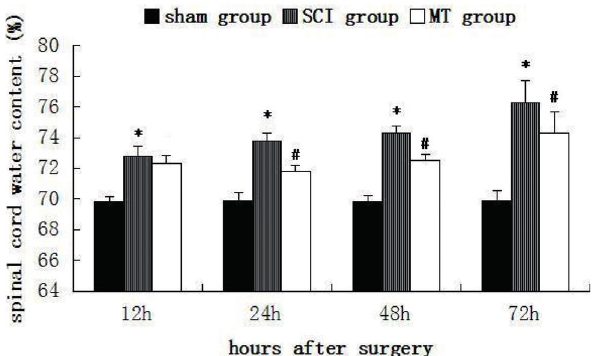
Fig. 2. Changes of AQP4 positive cells expression by IHC method at 24 and 72 h after injury (A: 24 h of Sham group, B: 24 h of SCI group, C: 24 h of MT group, D: 72 h of Sham group, E: 72 h of SCI group, and F: 72 h of MT group). The number of AQP4 positive cells in gray matter regions in SCI group was significantly up-regulated compared with that in Sham group at 24 and 72 h after injury. The number of AQP4 positive cells in MT group was significantly down-regulated compared with that in SCI group at 24 and 72 h after injury. Data present mean ± SD (n=5, * P <0.05 between Sham group and SCI group, # P <0.05 between MT group and SCI group, Scale bar=50